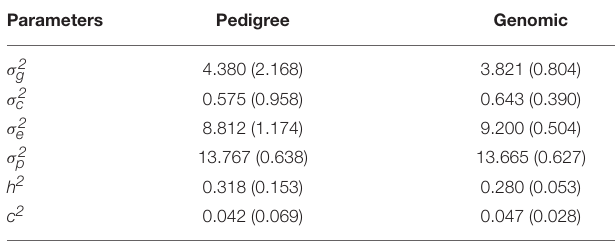
TABLE 1 | Estimates of variance components and heritability from pedigree and genomic information.